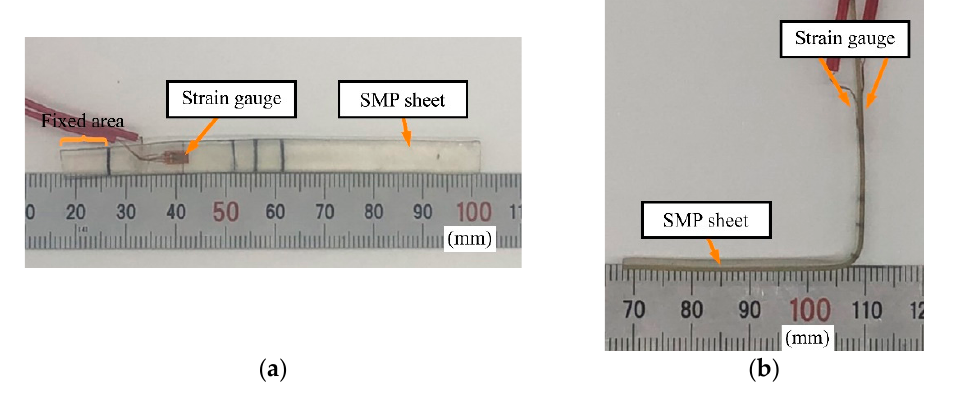
Figure 6. Prototype SMP FS. ( a ) Before bending. ( b ) After bending and fixing. Table 2. Dimensions of prototype SMP FS (average ± standard deviation from ten measurements).